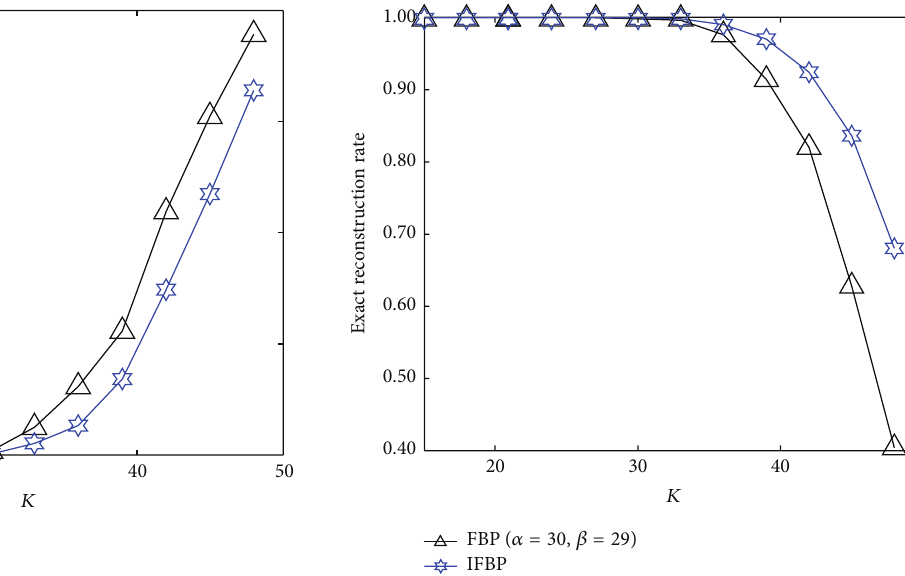
Figure 4: Average NMSE for the uniform sparse vectors ( 𝛼 = 20 , 𝛽 = 19 ).